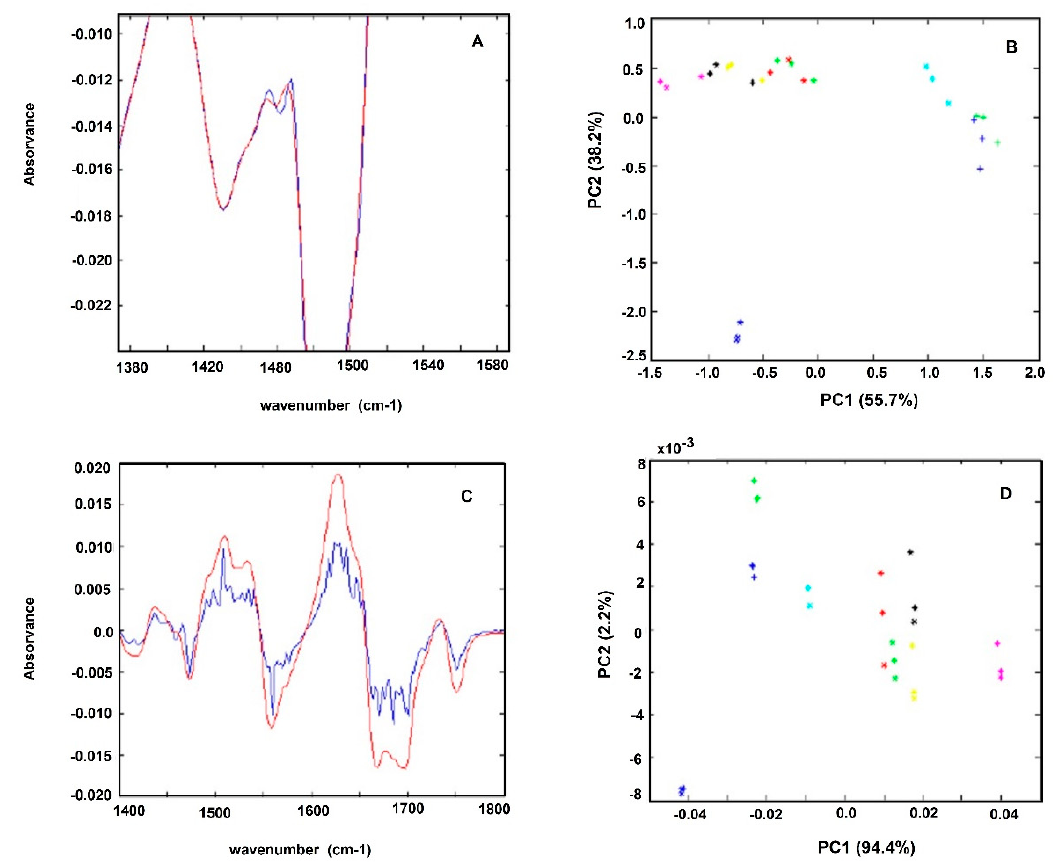
Figure 2. Effect of application of Savitzky–Golay filter on the: ( A ) FT-MIR spectra; ( B ) first derivative spectra ( B ). Only some regions of the spectra where the effect of the filter is high are shown. Effect on the PCA analysis using a: ( C ) normal spectral; ( D ) first-derivative spectra with a Savitzky–Golay filter. Legend of symbols: Blue—0 mg/L; Green—2.5 mg/L; Magenta—5 mg/L; Yellow—25 mg/L; Red—50 mg/L; Black—75 mg/L; Cyan—100 mg/L; Blue-cross—200 mg/L; Green (cross)—400 mg/L.